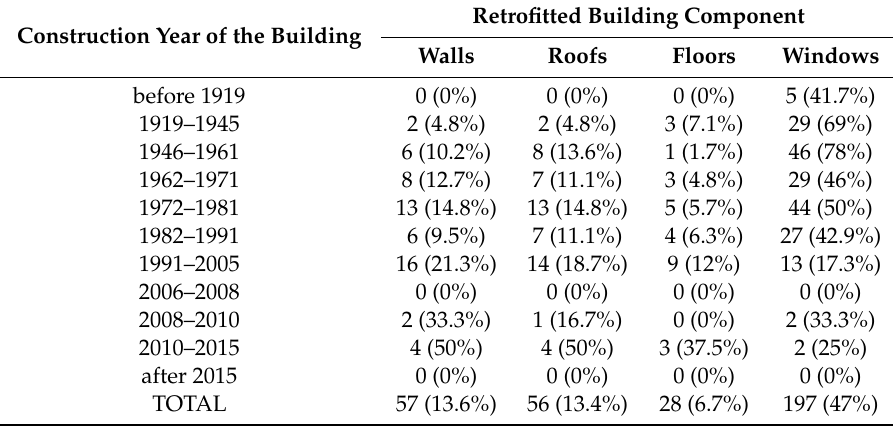
Table 5. Retrofitted building